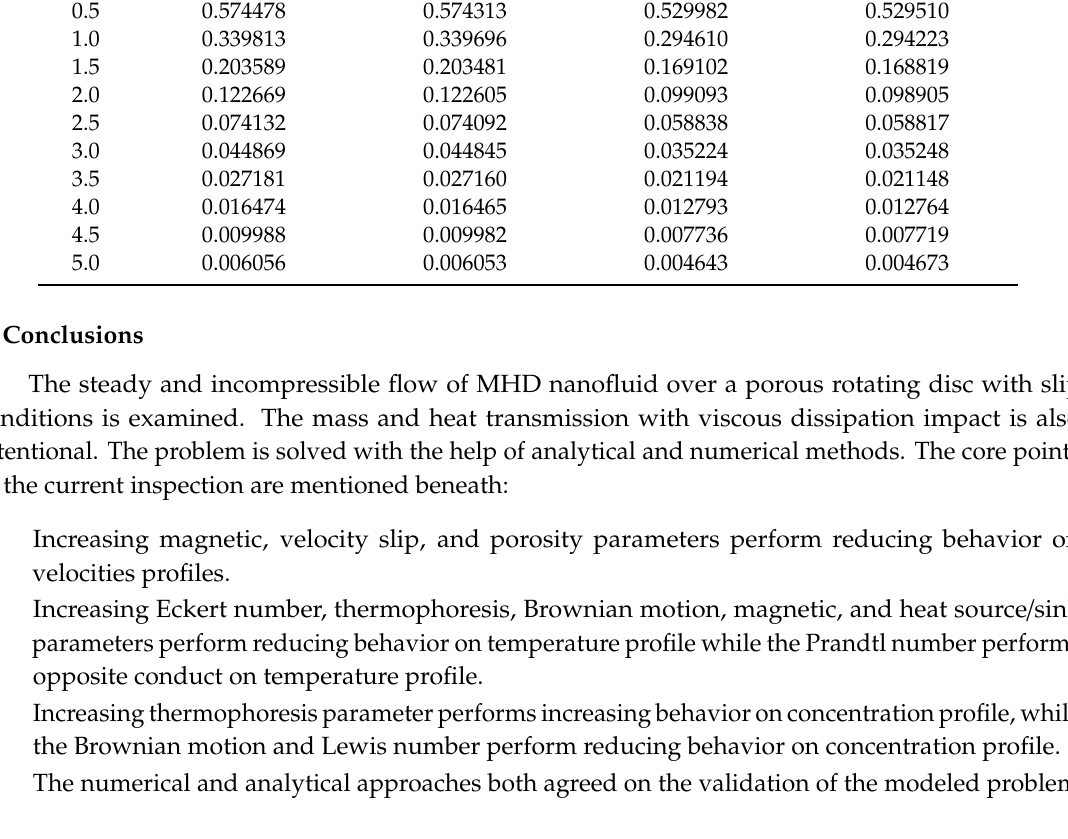
Table 5. Comparison of HAM and Shooting techniques for